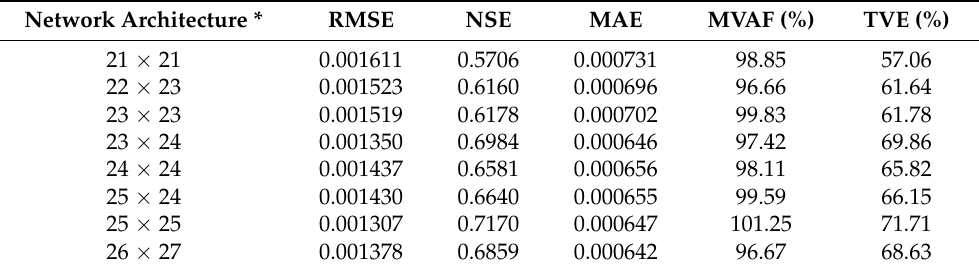
Table 3. Results of the SOFM model with different network architectures.